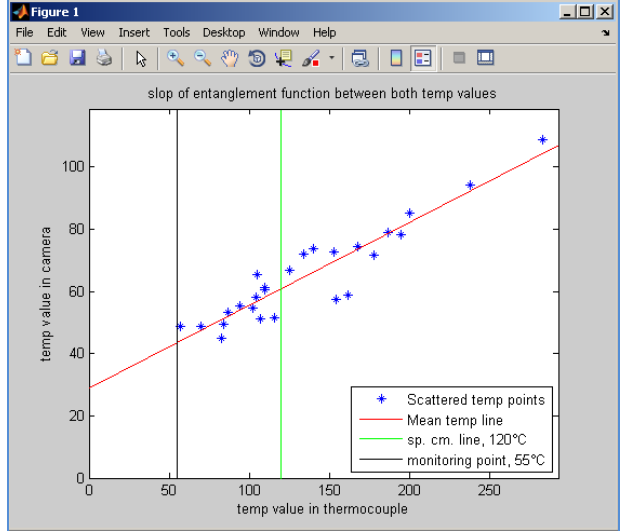
Figure 24. Compared graph of temperature value between camera and thermocouple